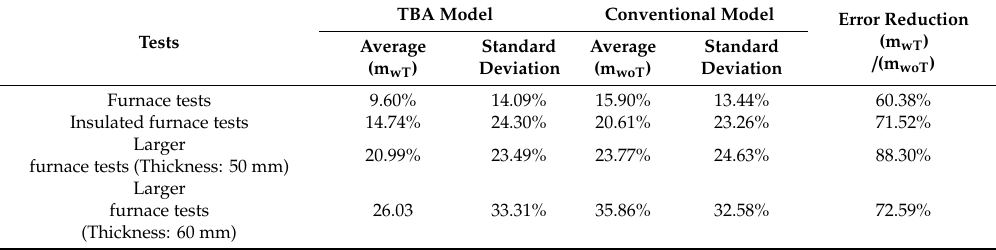
Table 3. Errors average and deviation of analysis results compared with the test